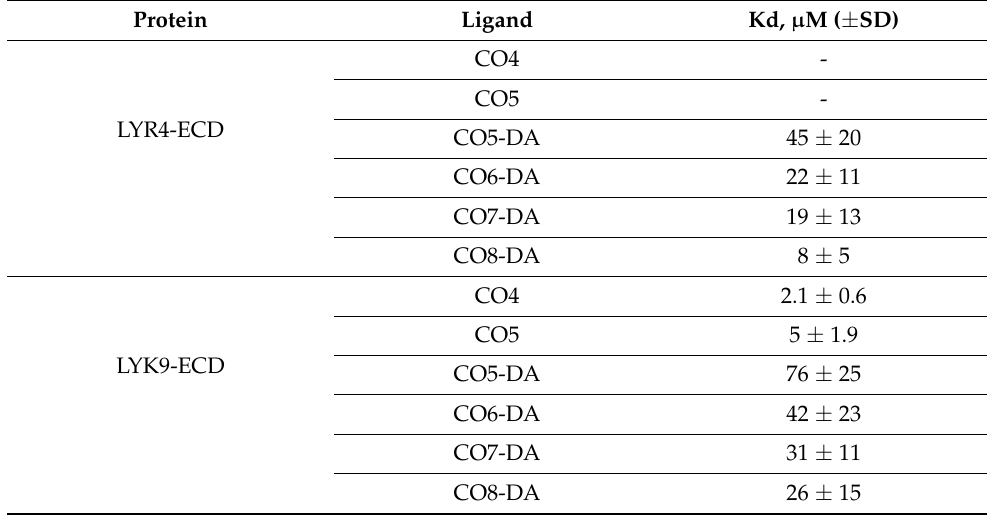
Table 2. The equilibrium dissociation constants of Ps LYK9-ECD and Ps LYR4-ECD with COs. Protein Ligand Kd, µ M ( ± SD) CO4 - CO5 LYR4-ECD